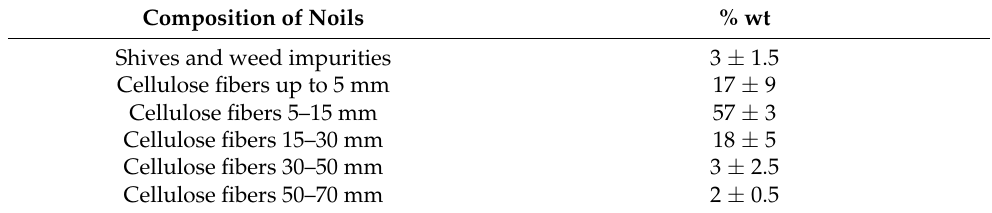
Table 1. Composition of linen noils. Composition of Noils Shives and weed impurities